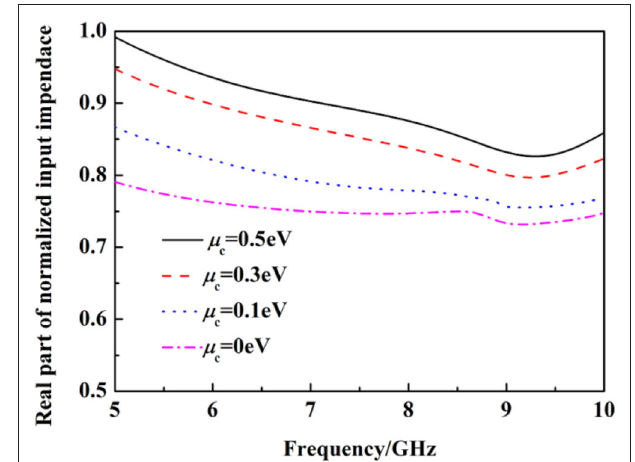
FIGURE 3 | The absorption of the metamaterial absorber under different Fermi levels.